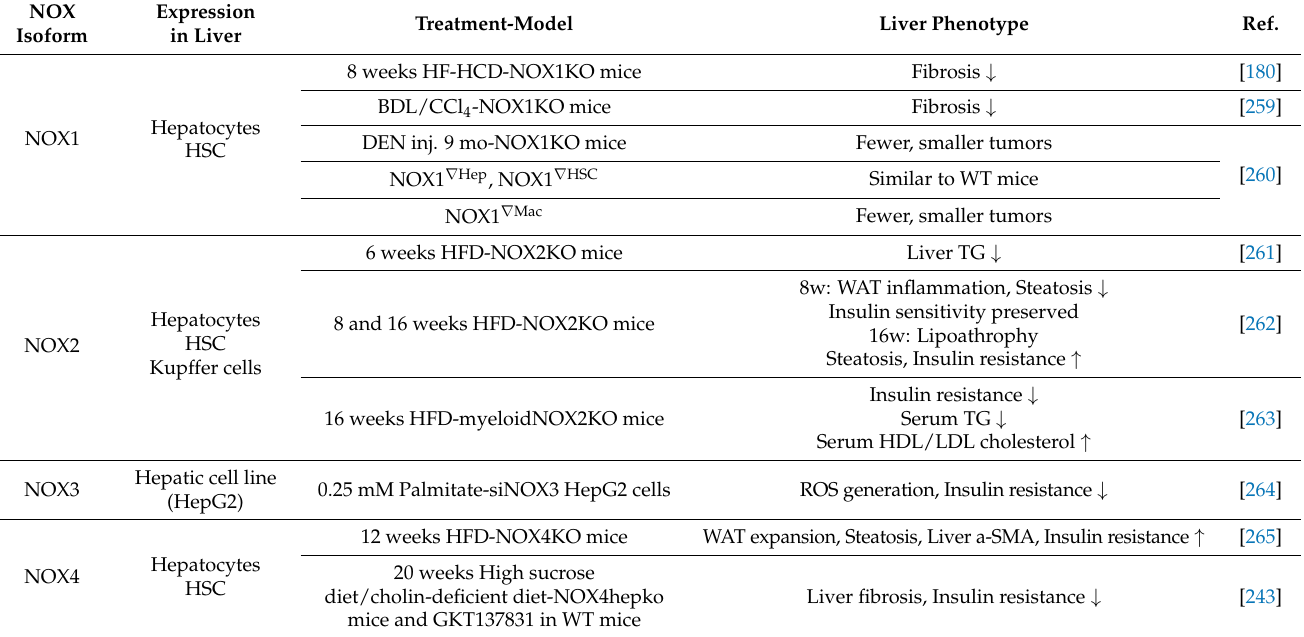
Table 1. Liver phenotypes of selected NOX-deficient mouse